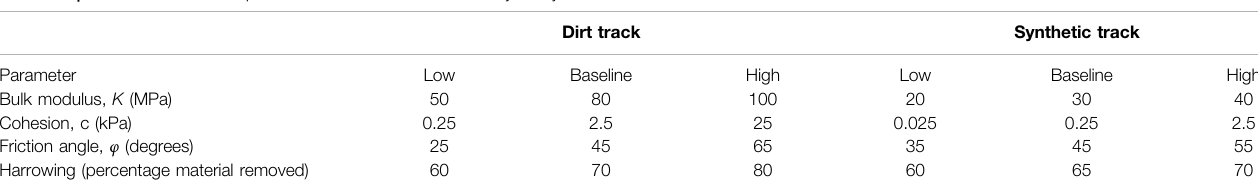
TABLE 2 | Variations in material parameters considered in sensitivity